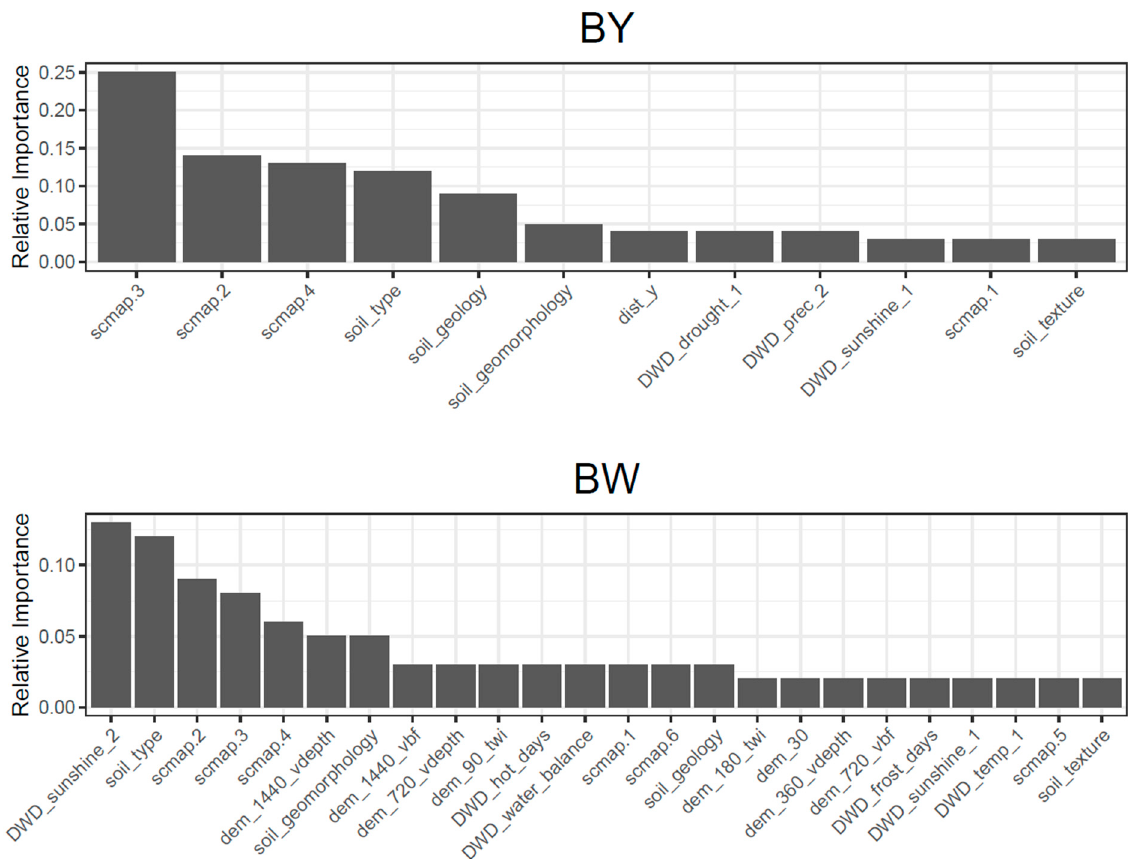
Figure 5. Relative variable importance of covariates in the combined models. Only covariates with relative importance above 1% are shown.